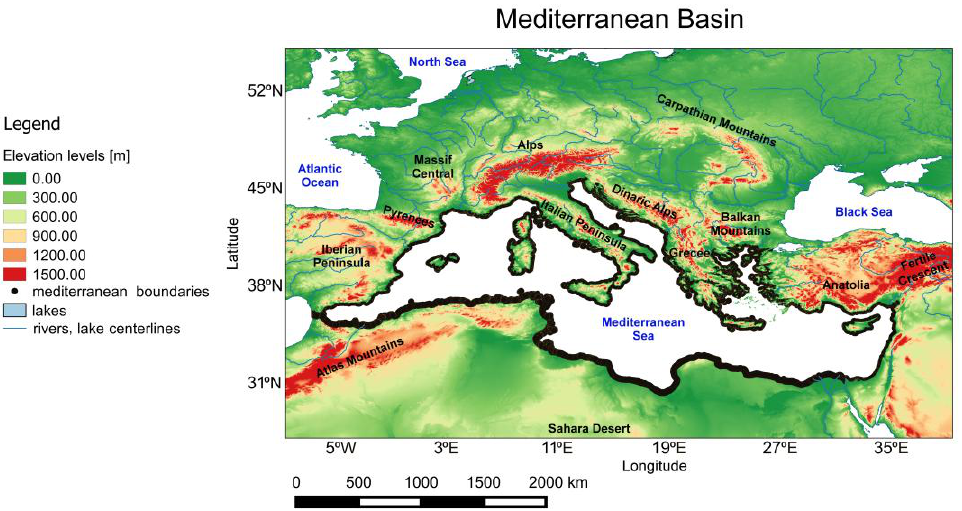
Figure 1. The black line contour indicates the area of the Mediterranean basin. The green-red colored portions represent elevation levels in meters (m). Data is taken from the HydroSHEDS project (Hydrological data and maps based on shuttle elevation derivatives at multiple scales (available online at https://hydrosheds.cr.usgs.gov).